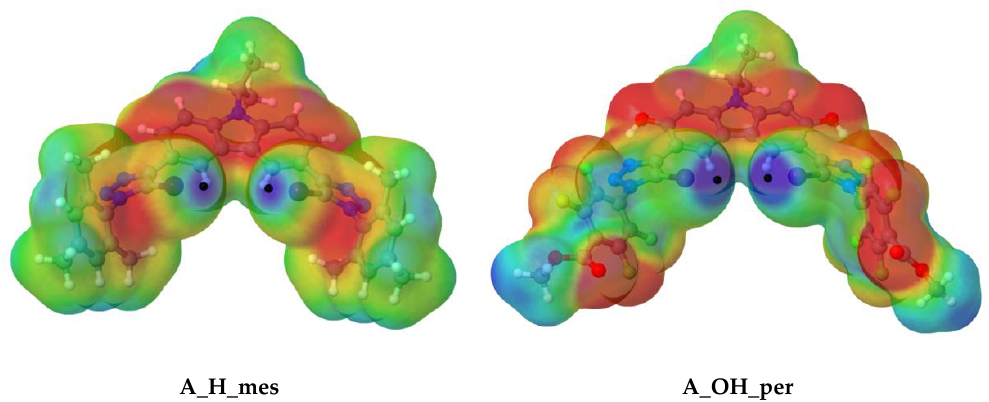
Figure 3. Molecular electrostatic potential on the 0.001 a.u electron density isosurface for A_H_mes